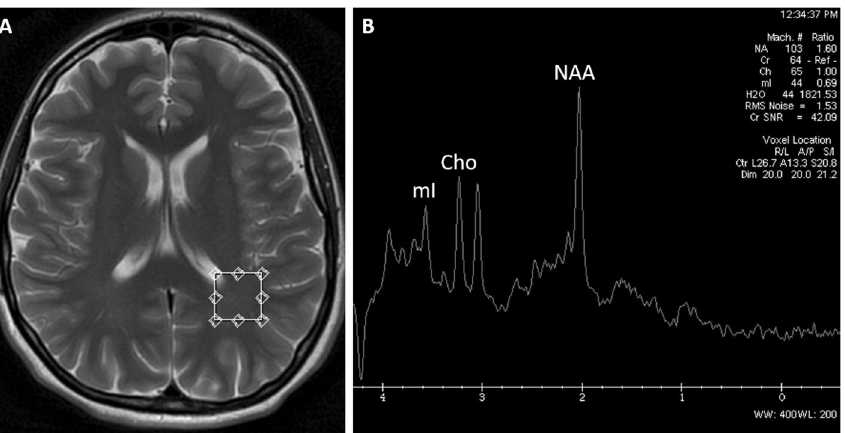
Figure 2. MR spectroscopy: axial T2-weighted image (A) presenting a single voxel placed in the left parietal white matter (PWM). The obtained spectrum (B) showed a decreased NAA/Cr ratio in PWM. Figures source: Department of General and Interventional Radiology and Neuroradiology, Wroclaw Medical University; images performed with a with a 1.5 T SignaHdx MR scanner (GE